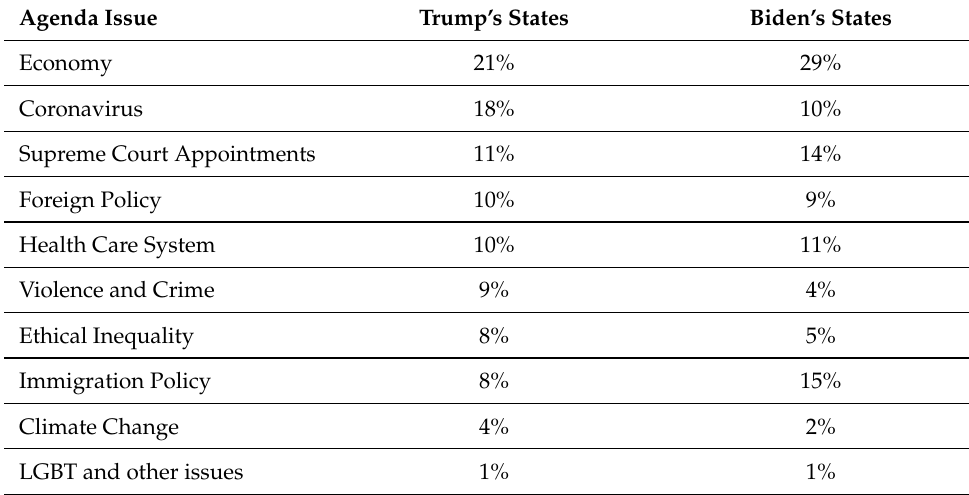
Table 7. Sentiment analysis based on agenda issues, sorted on states won by